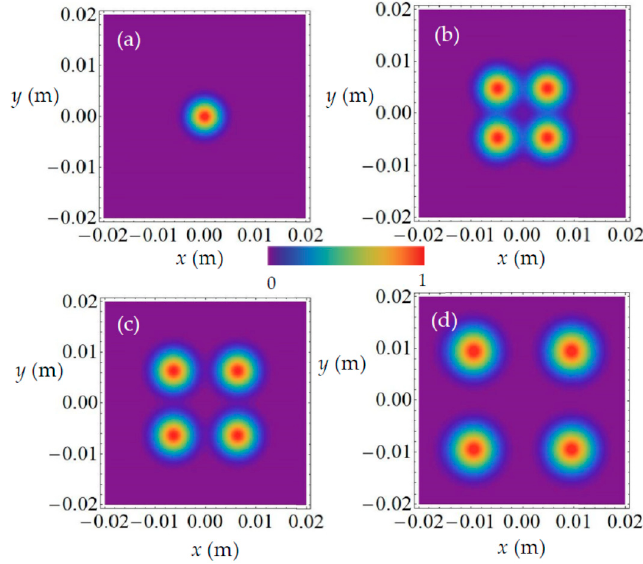
Figure 4. Density plots for the normalized spatiotemporal intensity I ( x , y , t , z ) (Equation (20)) of SCTLGSM pulsed beam in the x – y plane at some propagation distances ( a ) z = 0, ( b ) z = 30 m, ( c ) z = 40 m, ( d ) z = 60 m and for t = 0, s = 0, m =